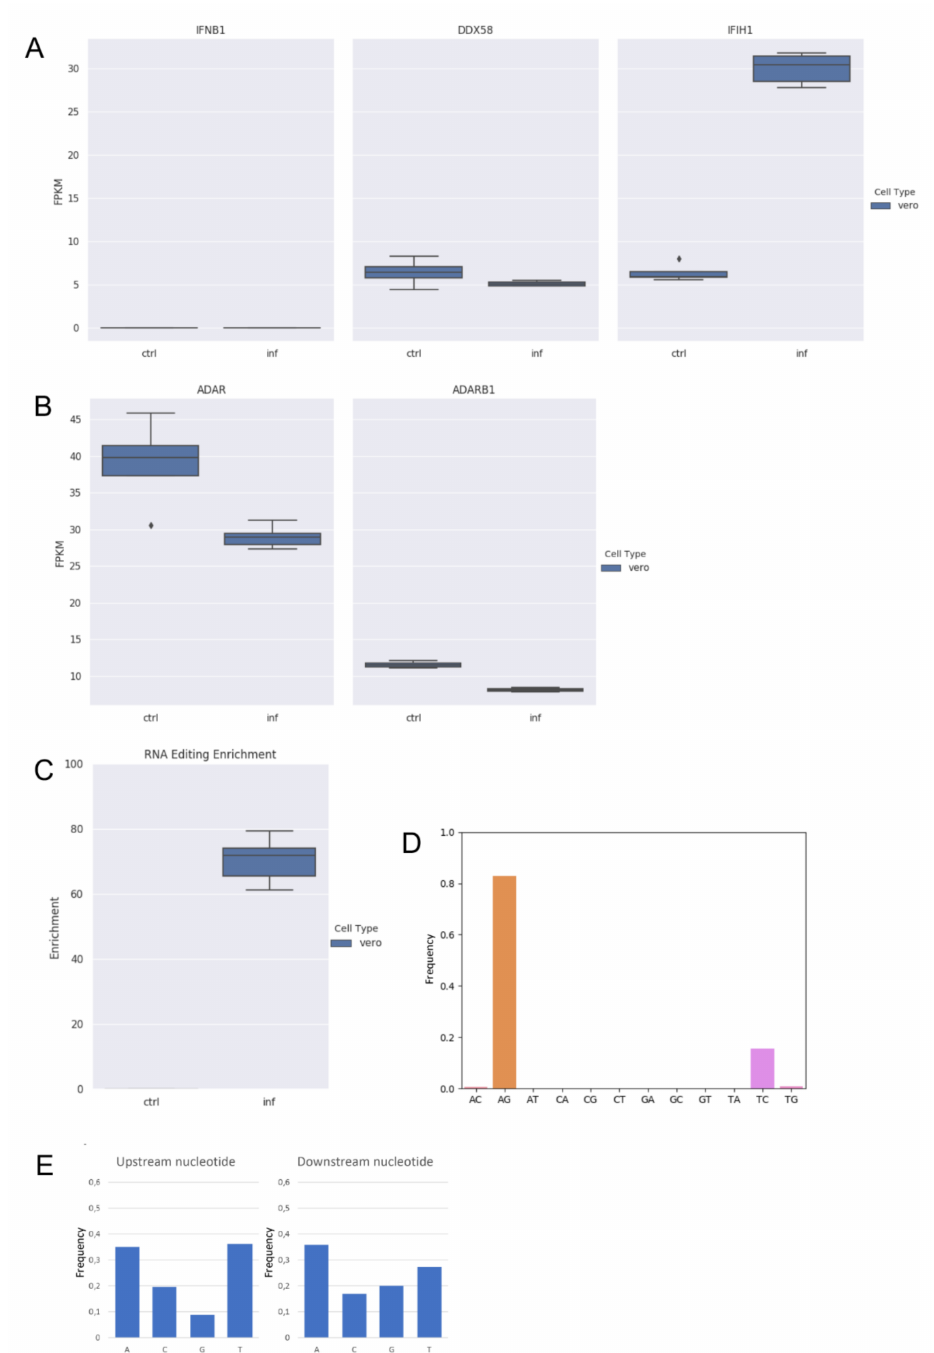
Figure 2. RNA editing and expression of key genes in RNAseq data from infected (inf) and uninfected (ctrl) Vero cells. ( A ) Gene expression of type-I interferon (IFNB1) and key sensor genes, DDX58 (RIG-I) and IFIH1 (MDA5) in Vero cells. Here, we report the expression of IFNB1 as representative gene of type-I interferons. Although IFIH1 were up-regulated, type-I interferons are not modulated. ( B ) Expression of ADAR1 (ADAR) and ADAR2 (ADARB1) genes in Vero cells. Although ADAR1 is downregulated in infected cells (DESeq2 adjusted p -value < 0.05), it is expressed in all samples. ADAR2 is also expressed in all samples but at very low levels. ( C ) Enrichment of unique hyper editing positions in Vero cells. ( D ) Distribution of hyper-edited reads identified in infected Vero cells. A-to-G and T-to-C events outnumber other substitution types. ( E ) Nucleotide context one base upstream and downstream the detected hyper-edited